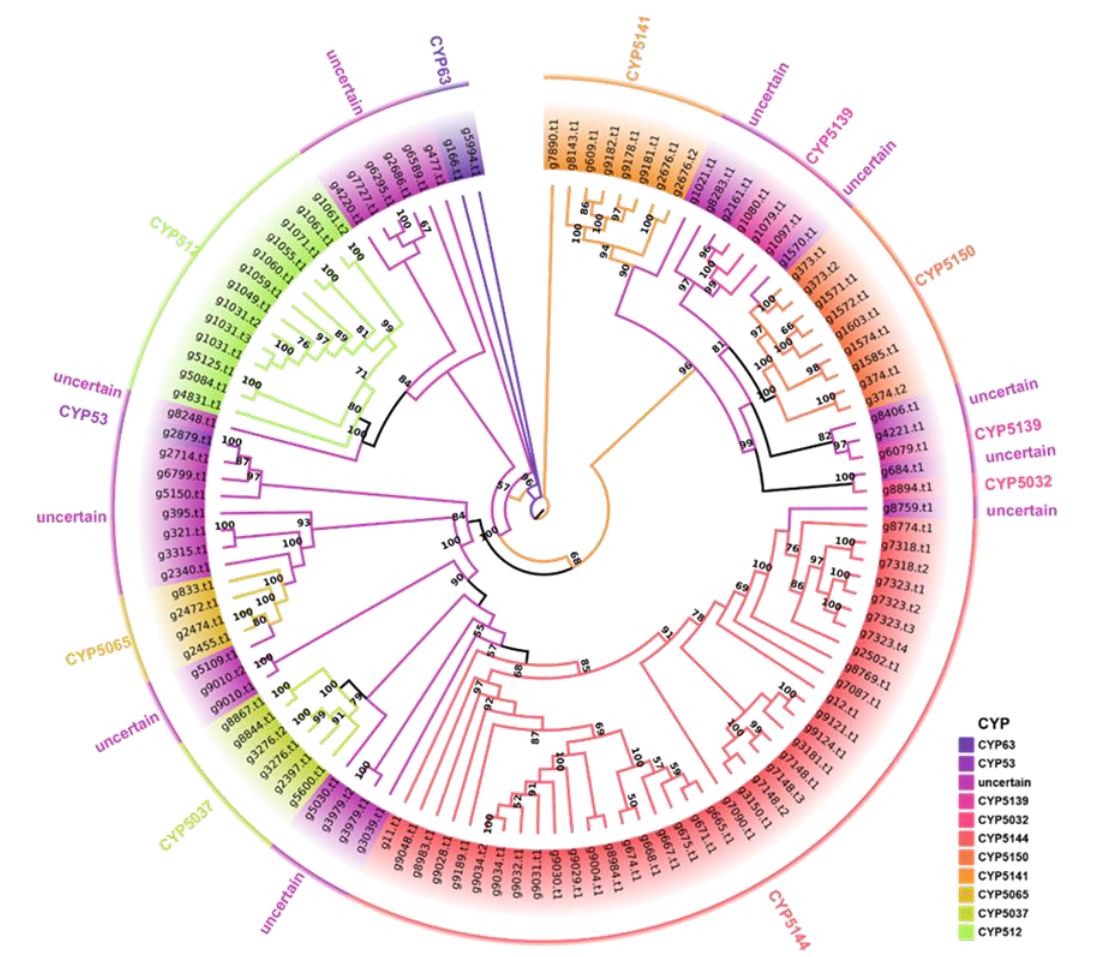
Figure 5. Maximum likelihood tree of 115 cytochrome P450s from A. bitorquis BH01. Each cytochrome P450 family is shown in a separate color, and the branch reliability value of over than 50 is marked on the corresponding branch node.